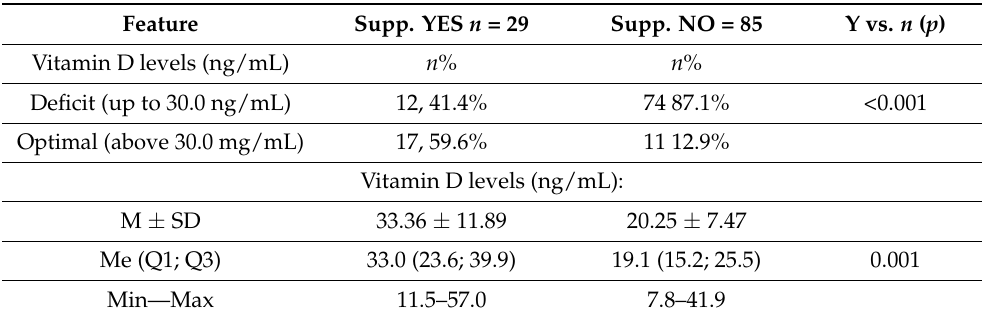
Table 2. Supplementation of vitamin